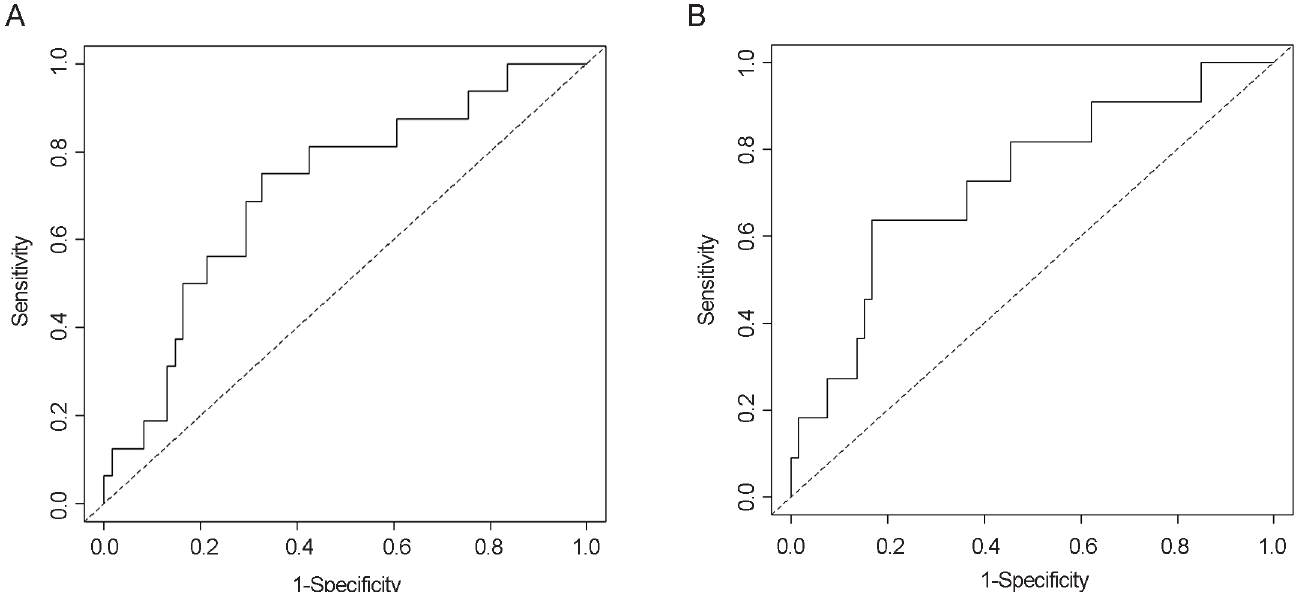
Fig 6. Receiver operating characteristic analysis for maximal change from Last Visit to predict catheter occlusion within 10 days. (A) Any occlusion event and (B) an occlusion event requiring TPA therapy.